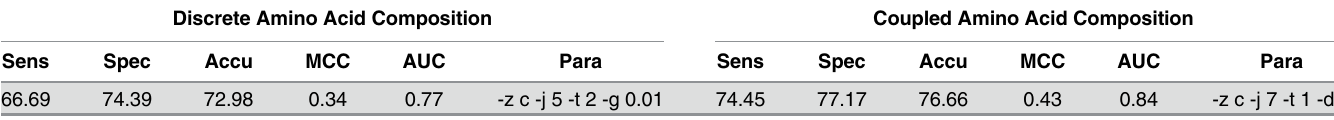
Table 3. Performance of discrete amino acid and coupled amino acid composition based SVM models during FFCV at 1 st tier. Discrete Amino Acid Composition Coupled Amino Acid